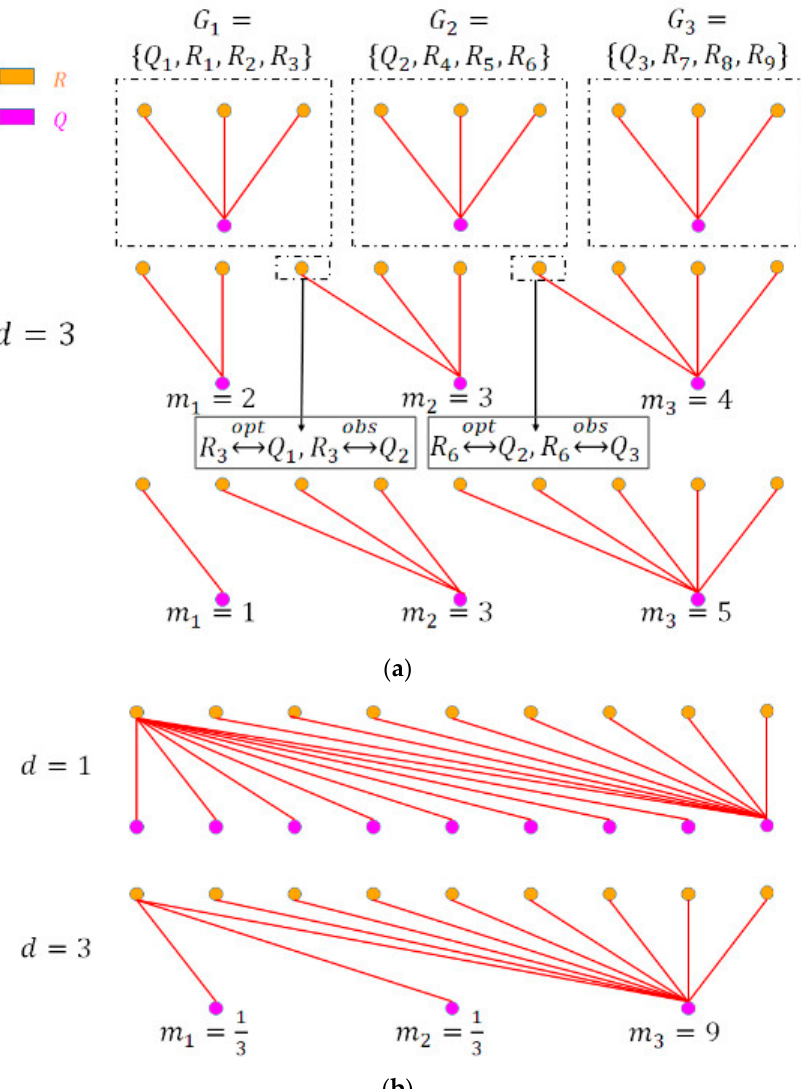
Figure 3. Calculation of the optimal alignment, error rate, and singularity score: ( a ) An example of alignment; ( b ) the alignment with the most severe singularity problem.